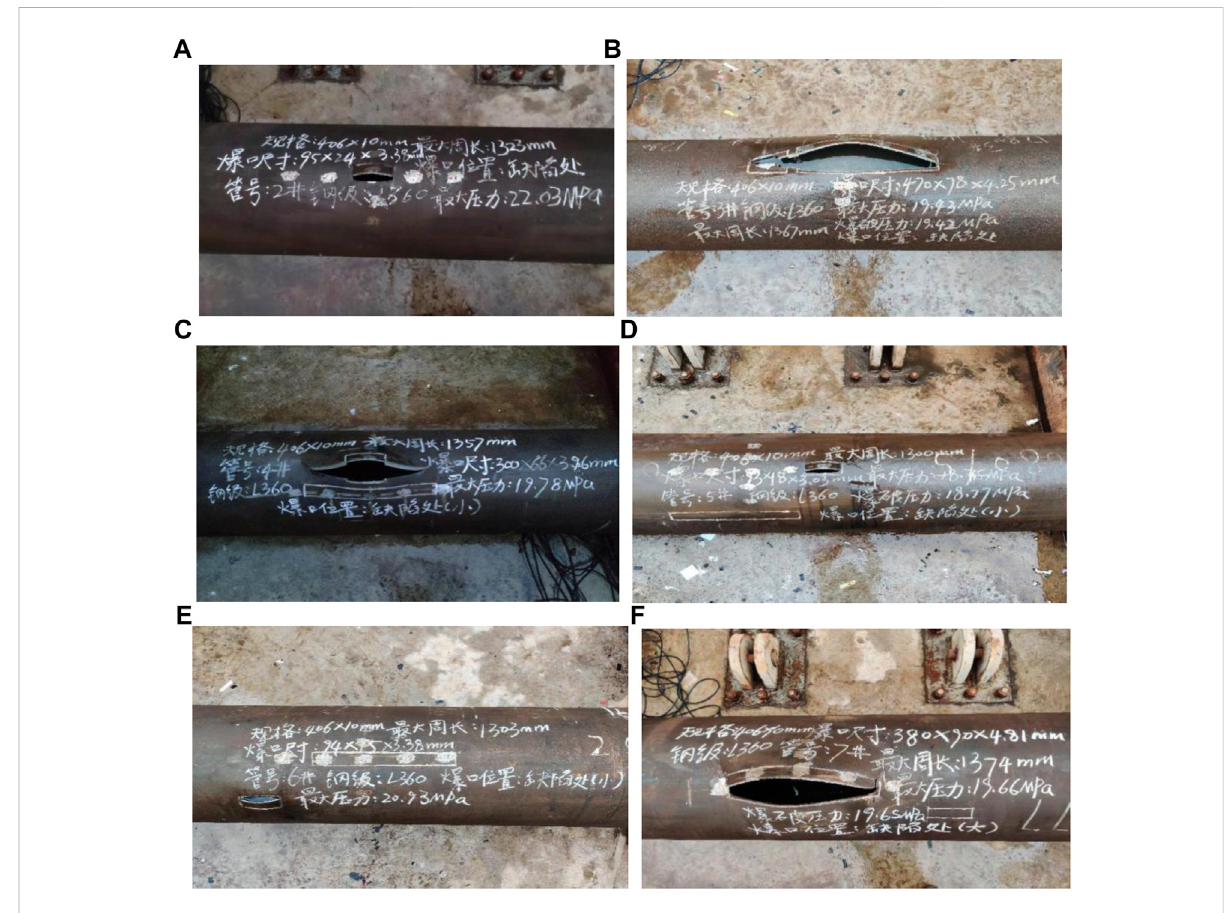
FIGURE 9 The rupture shape of six pipe samples, where (A – F) represent pipe samples 2# to 7#, respectively.